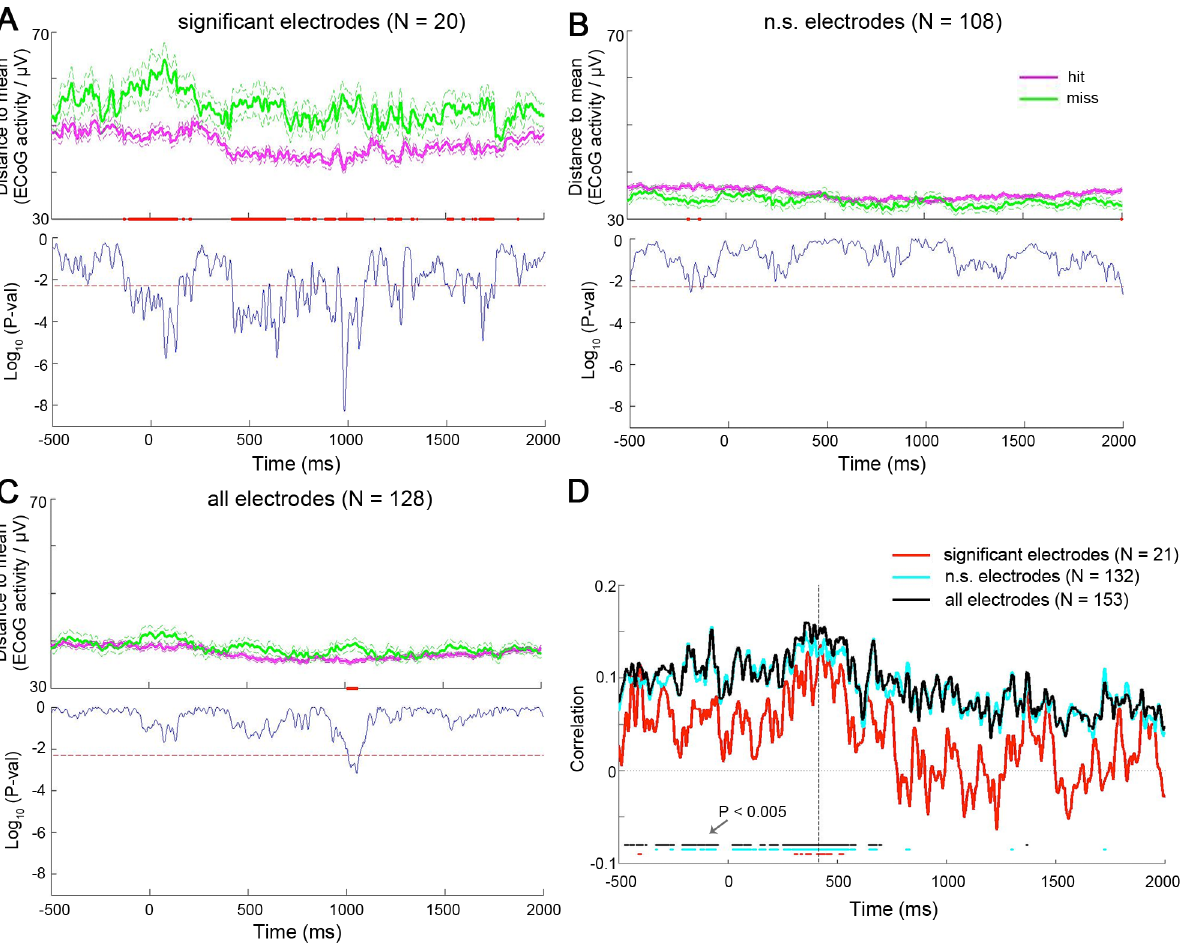
Figure 8. Analysis combining all electrodes (contralateral data). ( A ) Top: For each subject, D(t) was computed by combining across all significant electrodes in the electrode-based analysis (orange and white electrodes in Fig. 5A), and then averaged for hit and miss trials separately. Flanking dashed lines depict mean 6 SEM. Red dots: P , 0.005 for hit vs. miss trials, two-sample t-test. Bottom: the P-value time course of the two- sample t-test comparing D(t) between hit and miss trials. Dashed red line indicates significance level of P=0.005. ( B ) As in (A), except that D(t) was computed by combining across all remaining non-significant electrodes not included in (A). ( C ) As in (A), except that D(t) was computed by combining across all electrodes. For (A–C), all subjects except Pt # 3 were included, because Pt # 3 did not have any electrode showing a significant quadratic ECoG-hit rate relationship (see Fig. 5A). ( D ) Pearson correlation coefficient between D(t) and RT across all hit trials (pooled across all five subjects). D(t) was combined across all significant electrodes from the electrode-based analysis (orange/white/yellow electrodes in Fig. 6B) (red line), all remaining non-significant electrodes (blue line) and all (black line) electrodes. Dots at the bottom: P , 0.005 for significant D(t) -RT correlation, with D(t) computed using all significant (red), all non-significant (blue) or all (black) electrodes. Vertical dashed line indicates the time of median RT across all subjects.